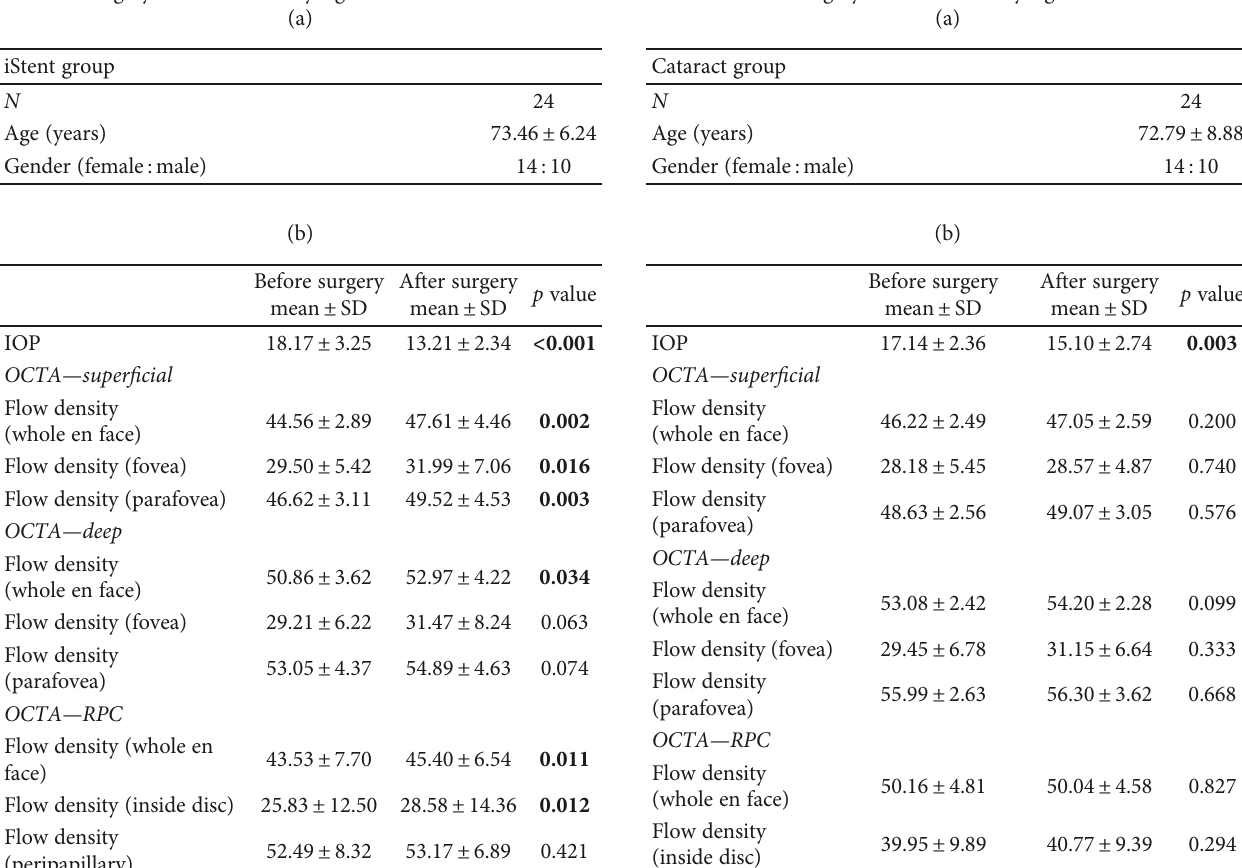
Table 2: Characteristics of the study population in the cataract group and values of fl ow density obtained in the indicated regions before and after surgery. Bold: statistically signi fi cant di ff